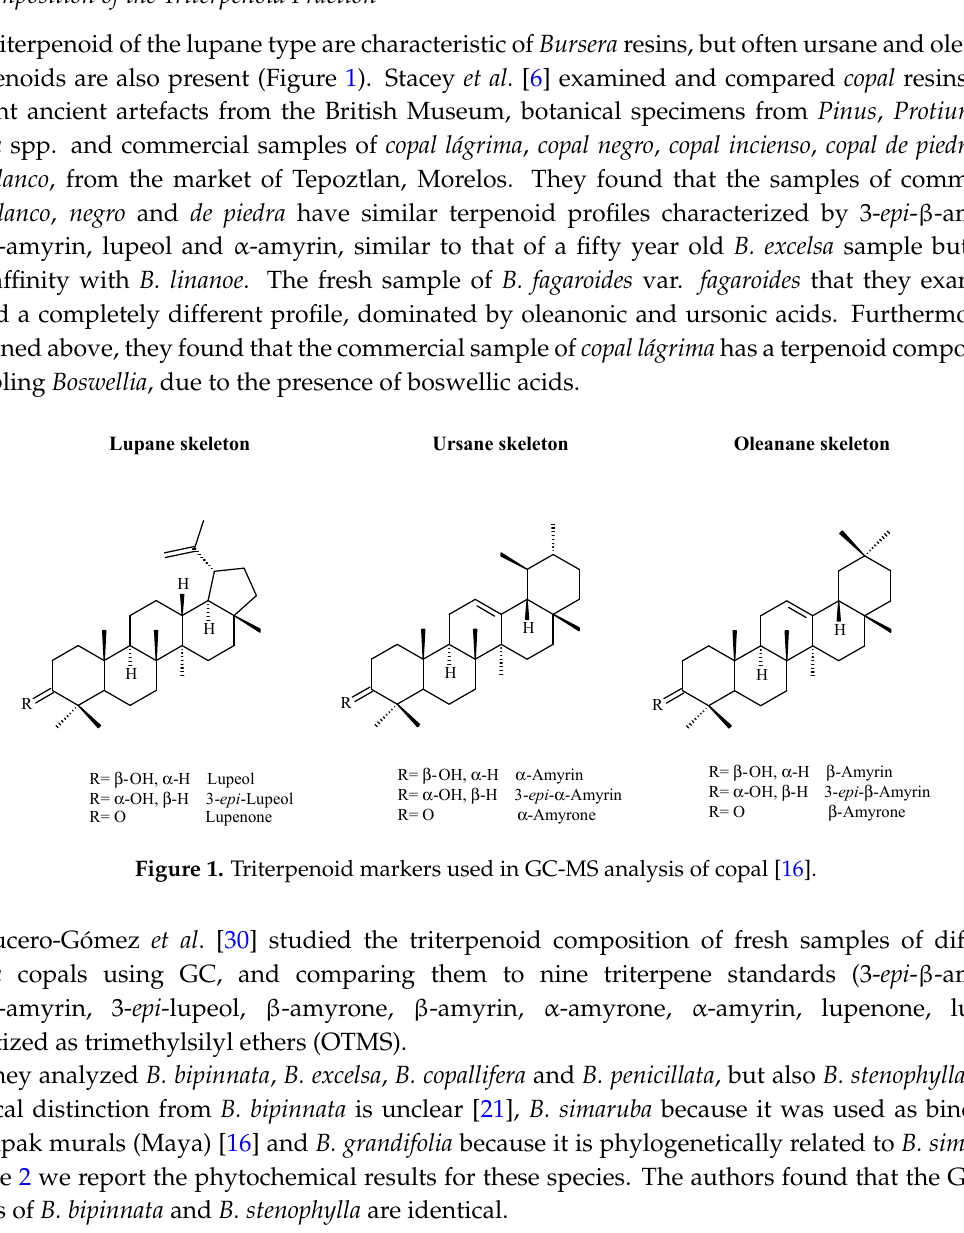
Table 2. Non-volatile terpene fraction composition of Bursera resins studied by Lucero-Gómez [16]. Compound